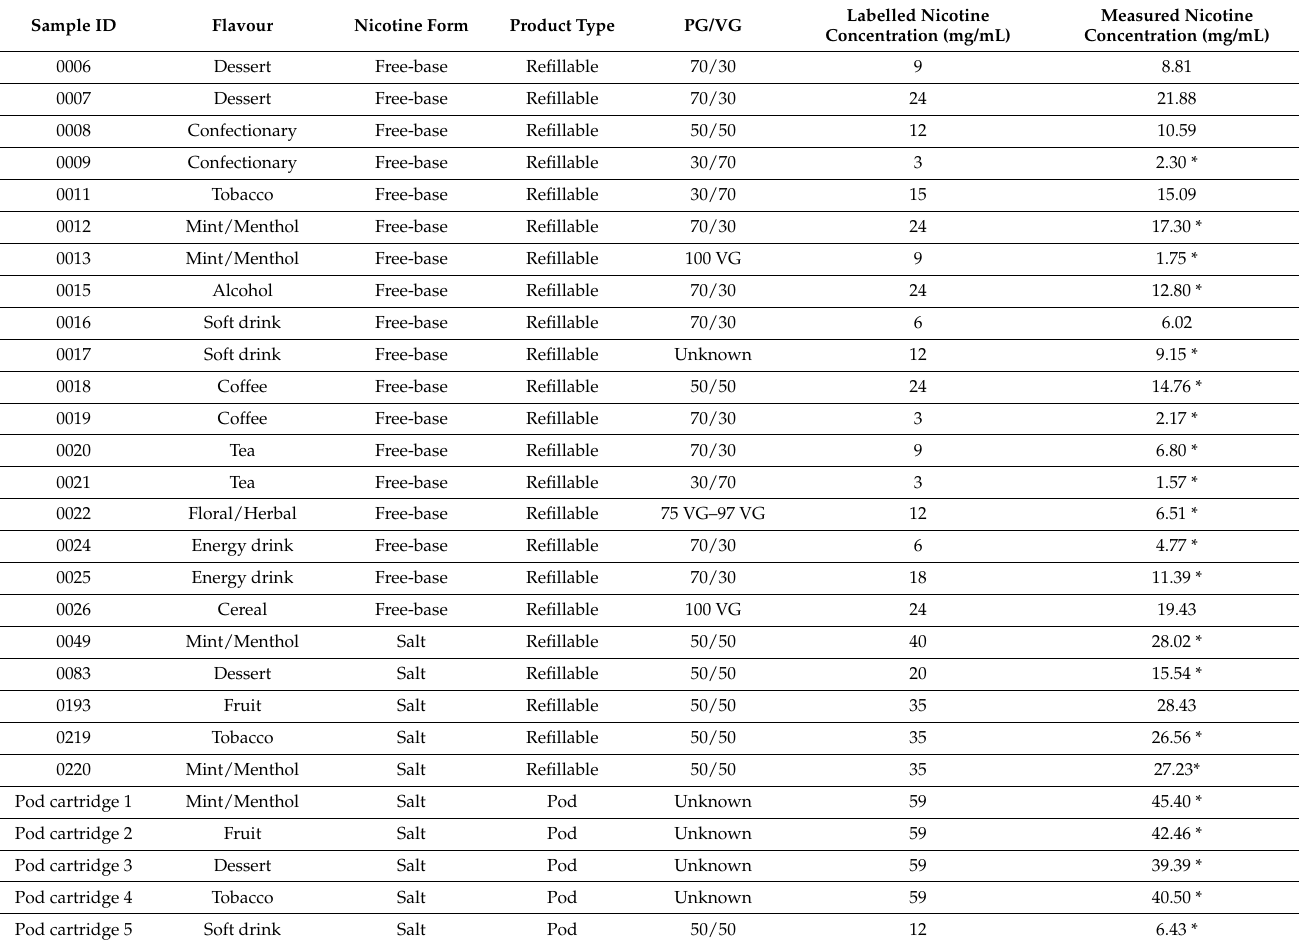
Table 3. Medium- and high-nicotine vaping liquids analyzed, (N = 28).